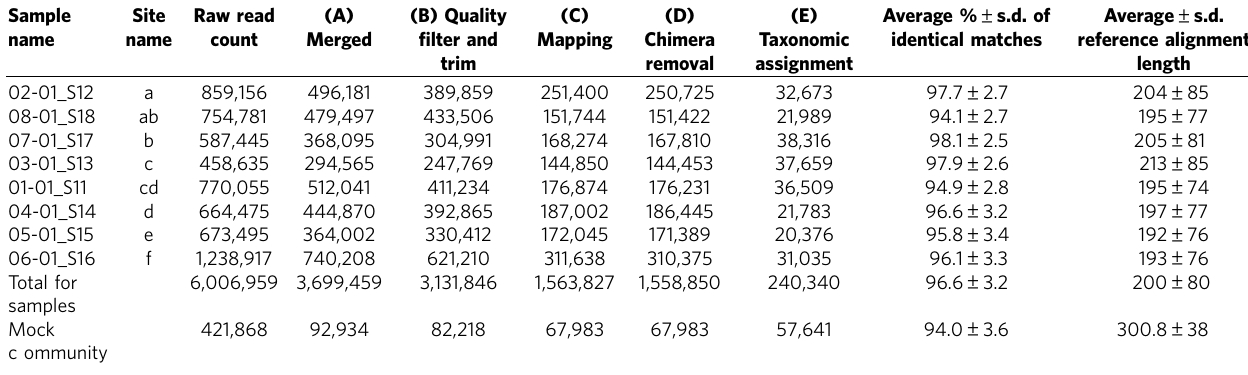
Table 1 | Sequences remaining after each bioinformatic filtering step and taxonomic assignment.